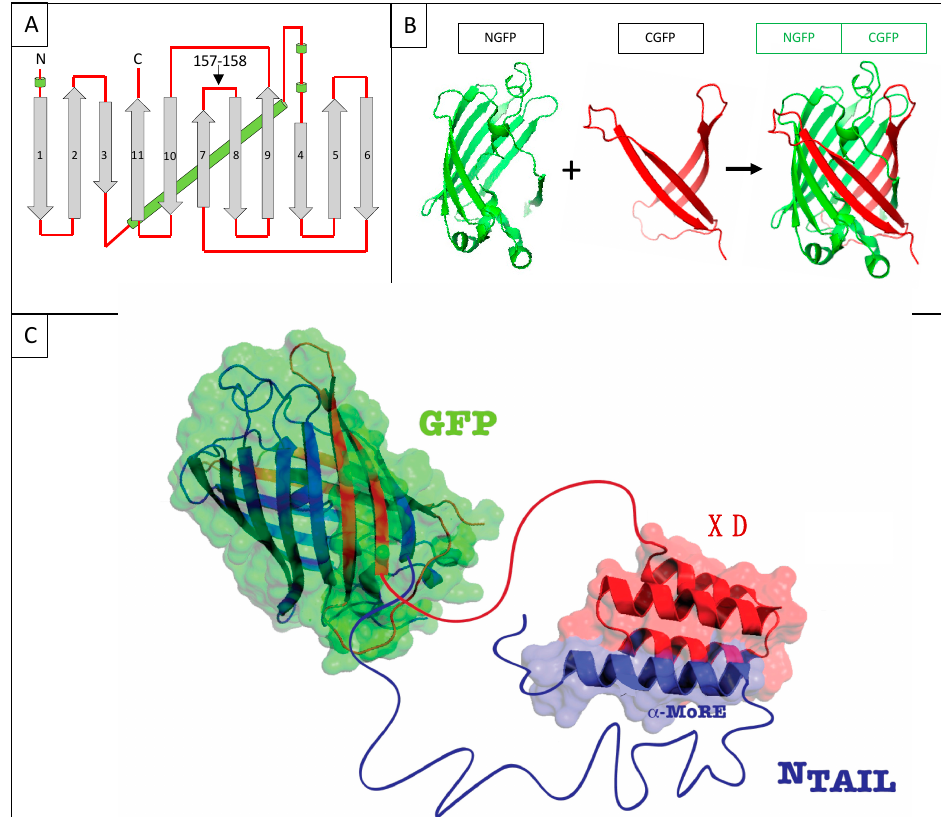
Figure 1. ( A ) GFP topology diagram. β -strands are numbered and represented as grey arrows, α -helices are represented as green cylinders and loops as red lines. The internal α -helix containing the chromophore is represented behind the structure. N, N-terminus. C, C-terminus. The cutting point between residues 157 and 158 is indicated. ( B ) Split-GFP reassociation. Cartoon representation illustrating how NGFP (1–157) and CGFP (158–238) reassociate to recreate the fluorescent protein. ( C ) Cartoon representation of the complex resulting from the assembly of NGFP-X and Y-CGFP fusion proteins, in this example X being measles virus N TAIL , and Y XD.